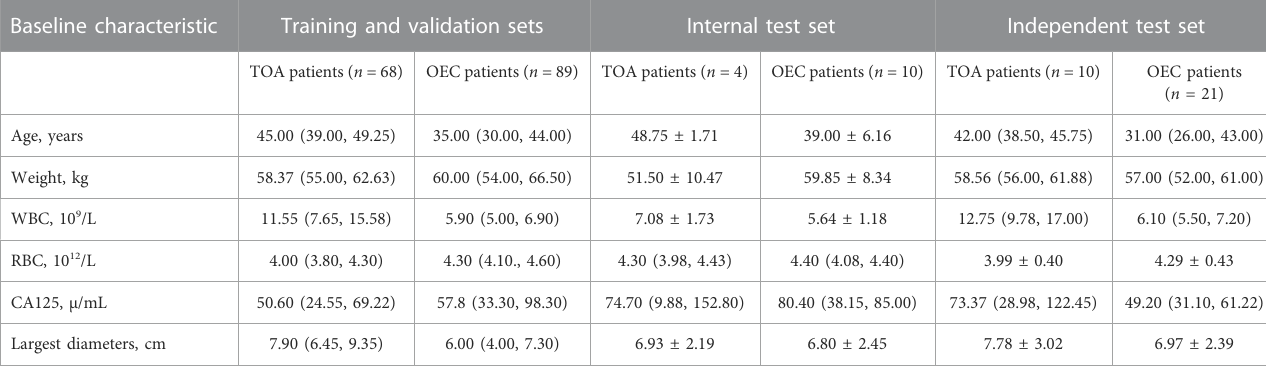
TABLE 1 Baseline characteristics of the subjects in this study. Baseline characteristic